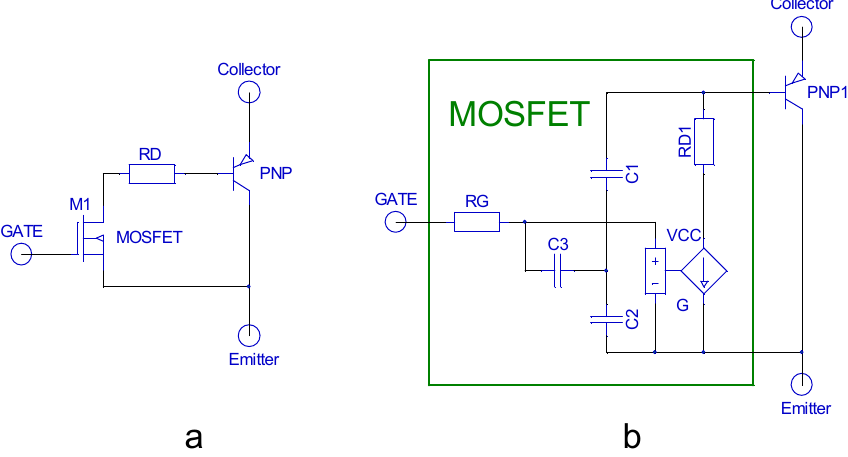
Figure 1. General circuit models of the IGBT showing the ( a ) MOS (metal–oxide-semiconductor) and PNP bipolar junction transistor and ( b ) three capacitors, C1, C2, and C3. In the first model, we used three diodes (D1, D2, and D3) to describe them (Figure 2). For the MOS transistor M1, which is included in the IGBT (Figure 1) circuit, we replaced the voltage-controlled current source G1 (Figure 2). The formulas used in our model accurately describe the law of change in the capacity of the p–n junction, according to the voltage across the p–n junction.